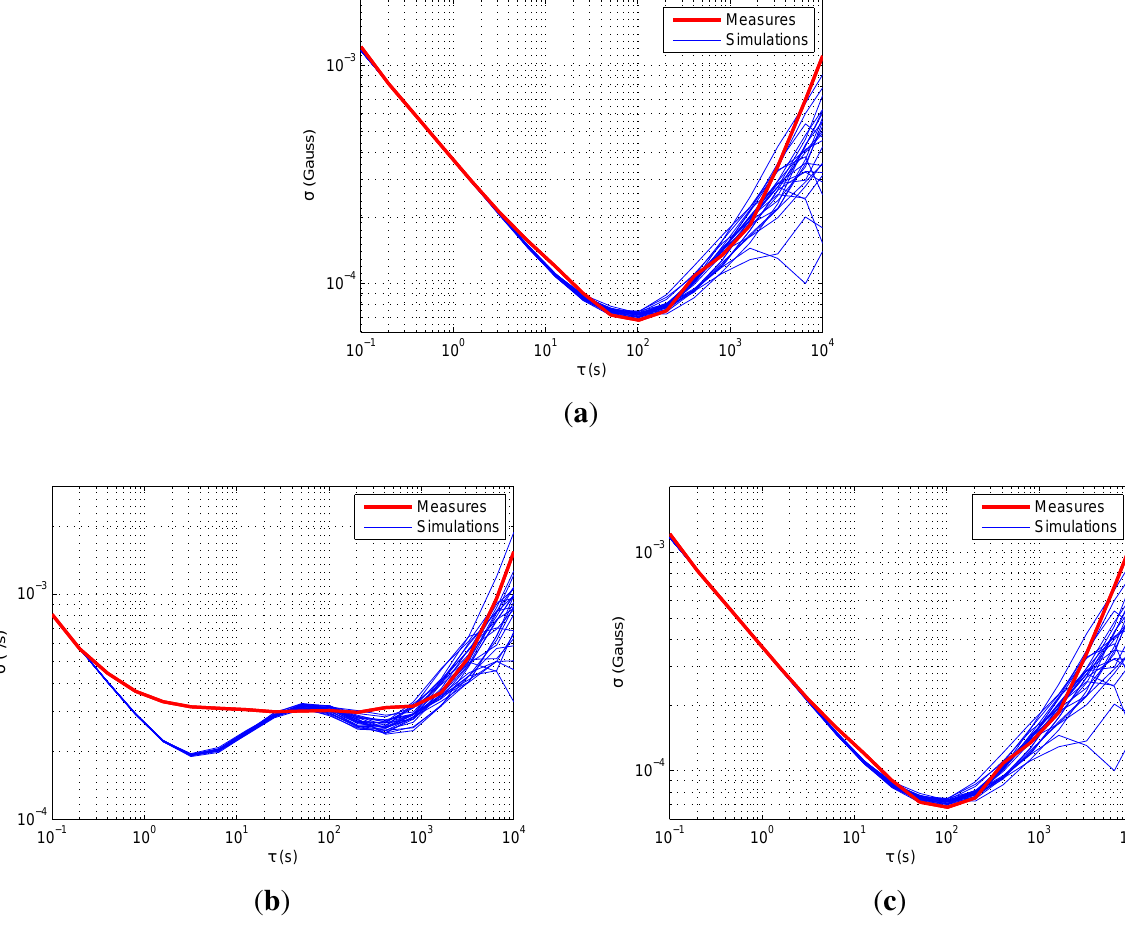
Figure 9. Comparison of Allan variance plots for different simulations and one real measurement. ( a ) Accelerometer; ( b ) rate gyroscope; ( c )